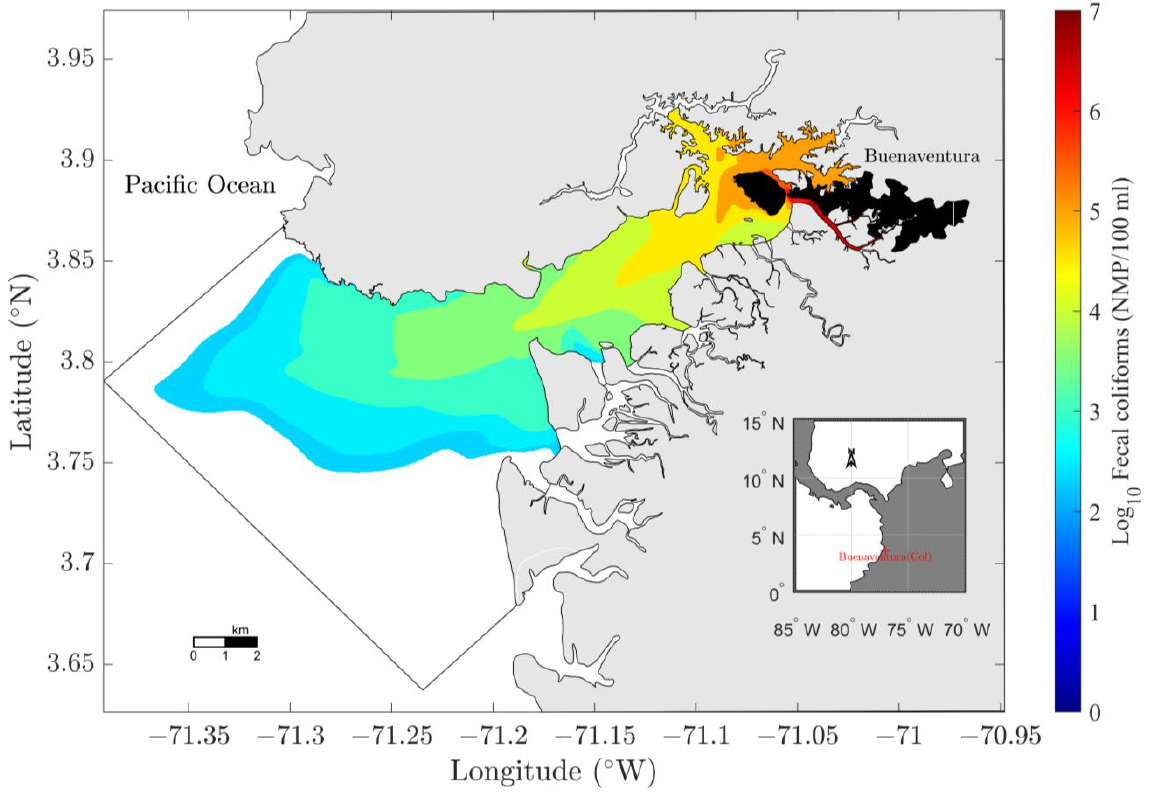
Figure 13. Spatial distribution of the maximum fecal coliform concentration in Buenaventura Bay in scenario two.